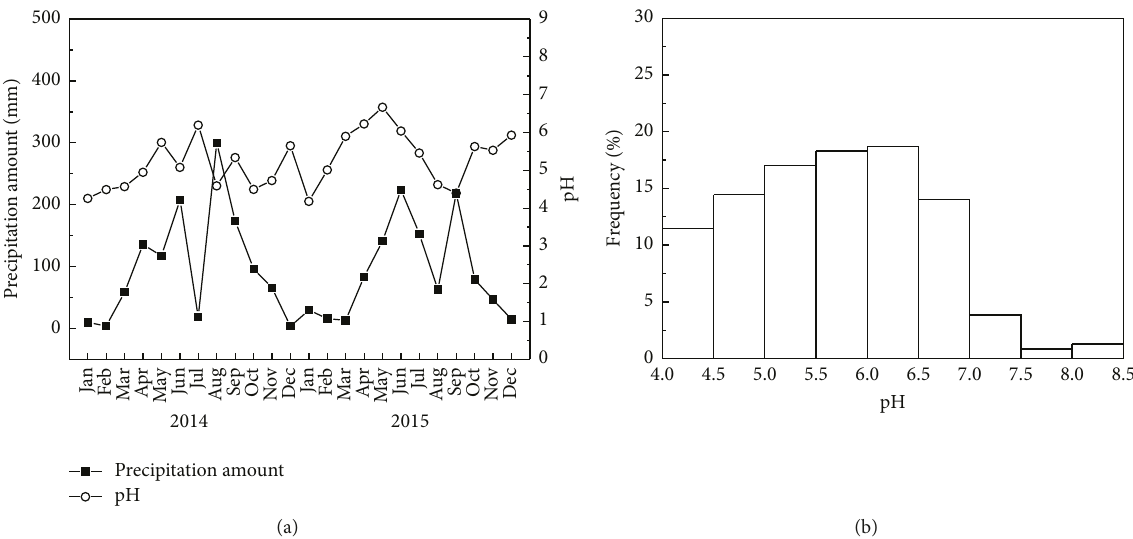
Figure 2: (a) Monthly precipitation amount, VWM pH, and (b) pH frequency distribution of the precipitation in Wanzhou.